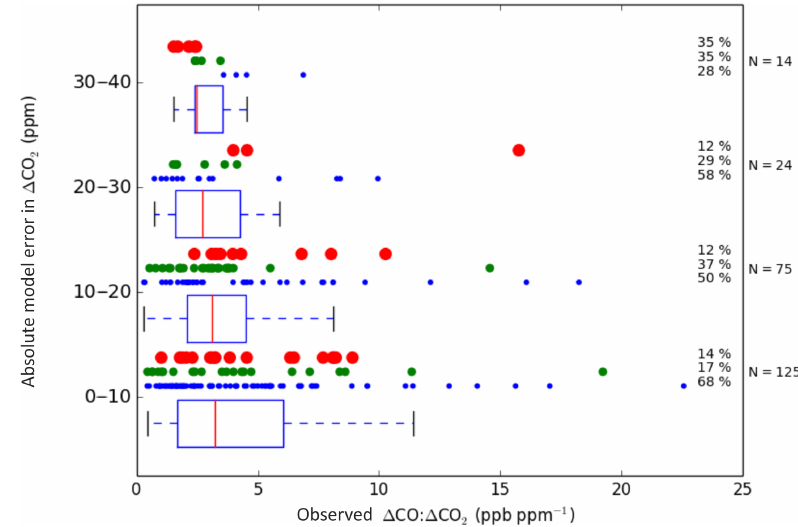
Figure 5. This figure shows four classes of the absolute model error in (cid:49) CO 2 compared with the Zweth measurement site. For each class two quantities are displayed. (1) A whisker plot of observed (cid:49) CO : (cid:49) CO 2 , which shows that the largest absolute (cid:49) CO 2 model error ( y axis) is related to small observed concentration ratios ( x axis). This indicates an important role for low-ratio stack emissions (industrial and power plant sources) in the large model error class. (2) A coloured scatter plot for which data points are divided into three classes based on the absolute error in simulated wind direction ( < 20 ◦ in small blue dots on bottom row, 20–40 ◦ in larger green dots on middle row and > 40 ◦ in large red dots on top row). Each dot represents 1h. The percentage contribution of each wind direction error class to the total number of data points ( N ) is shown on the right. These numbers show that the model error in wind direction also plays an important role in the (cid:49) CO 2 model error. Table 5. Statistics for CO 2 point source peaks at Zweth in four different model simulations as compared to observations. N is number of hours included, and the slope is based on a linear regression. (cid:49) CO : (cid:49) CO 2 denotes the mean ( ± 1 σ standard deviation) of the urban plume concentration ratio in ppbppm − 1 . Model run R 2 (cid:49) CO : (cid:49) CO 2 (cid:49) CO 2 slope N WRF-Chem 0.30 0.9 ( ± 1.5) 0.82